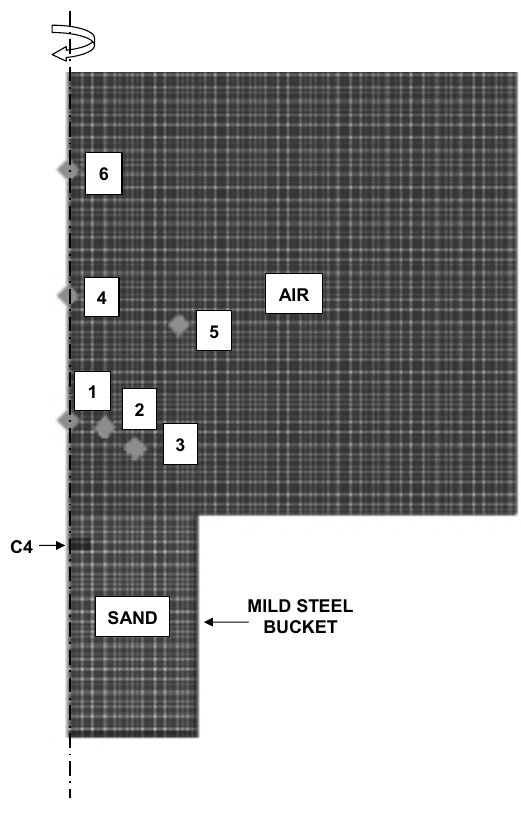
Fig. 5. Computational sub-domains used in the present